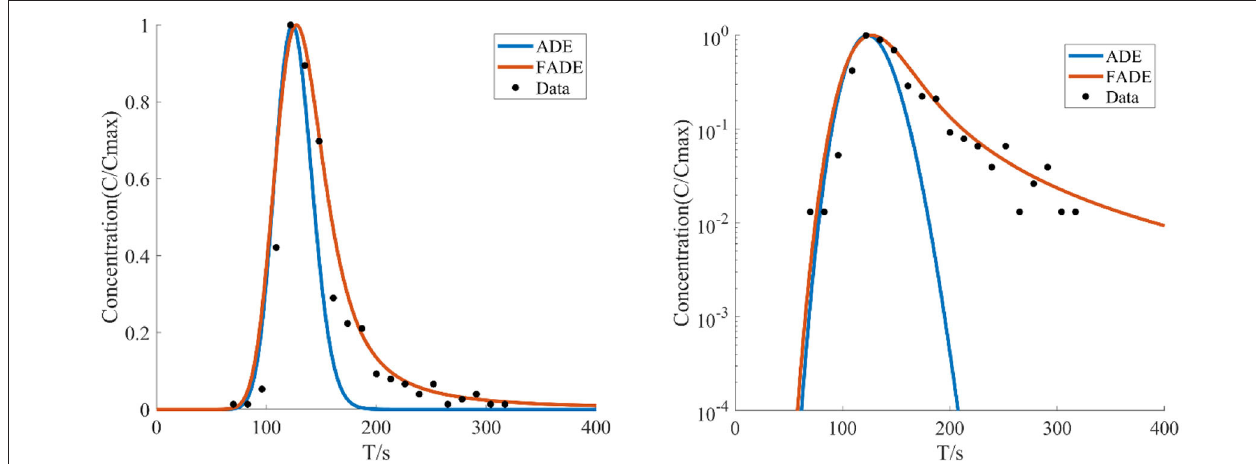
Frontiers in Physics |